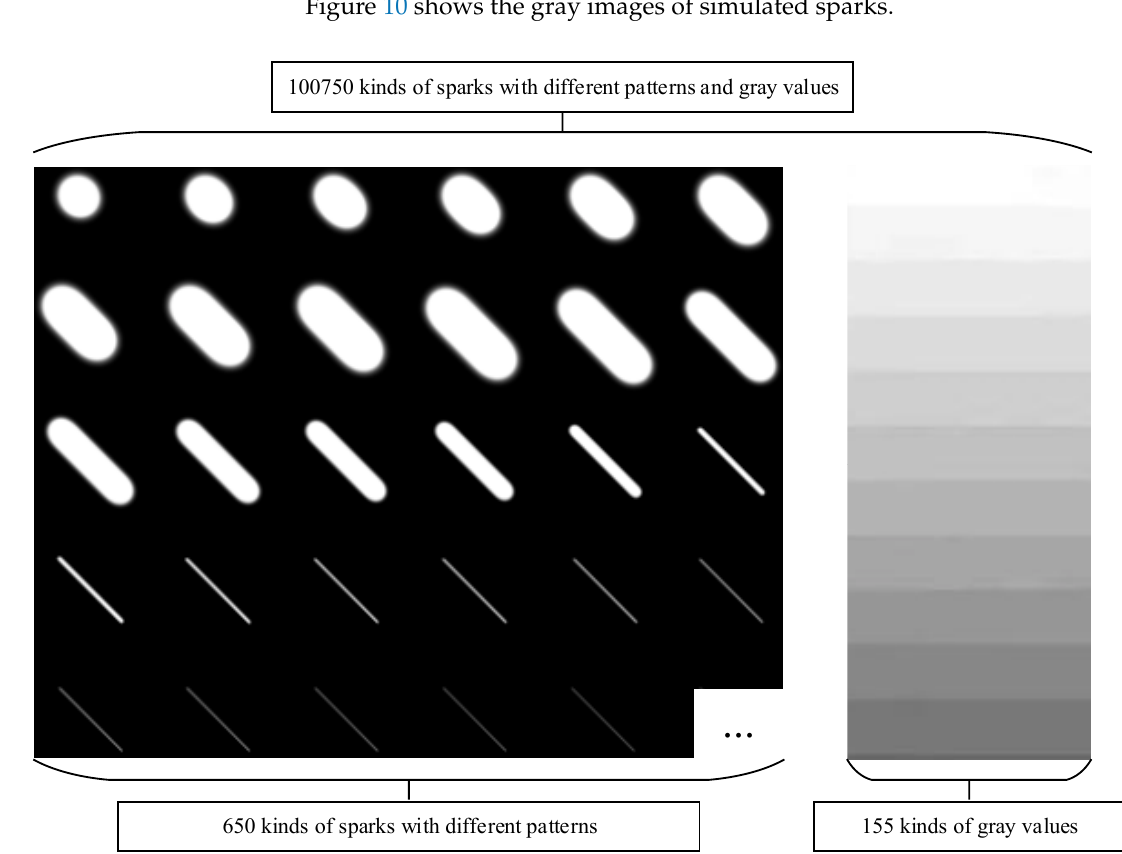
Figure 10. Gray images of sparks in 155 different gray values and 650 different shapes generated by the Gaussian function.